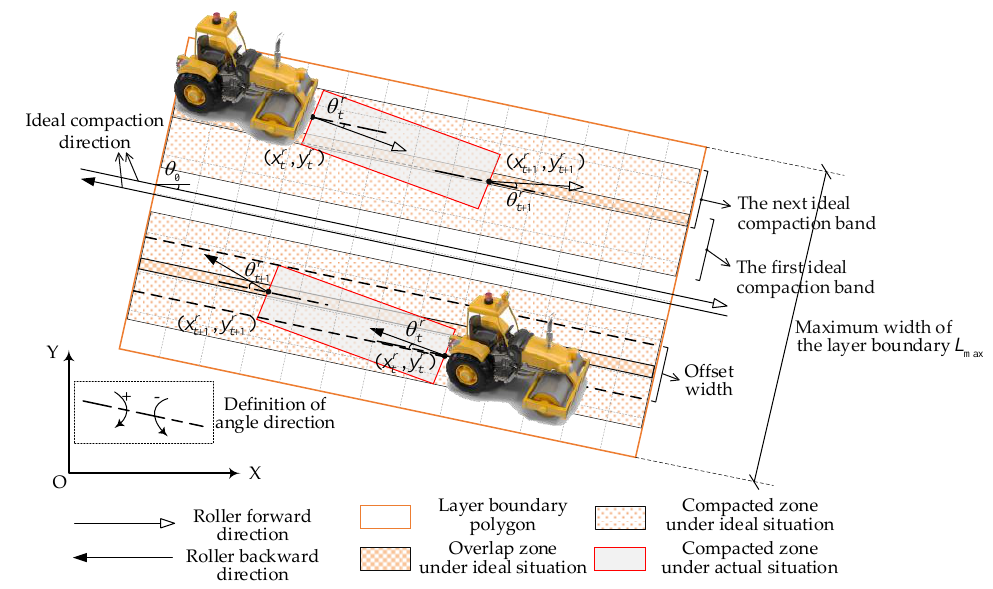
Figure 2. Overview of a filling layer.